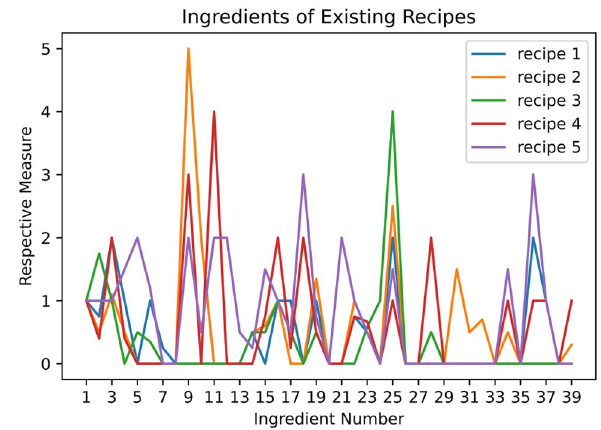
Fig. 6 Predicted taste ratings with custom loss function